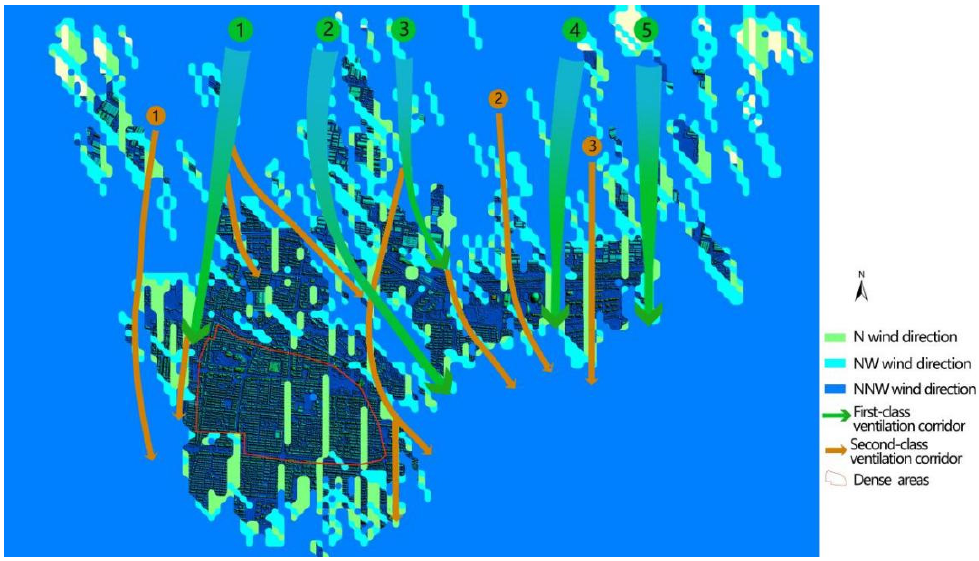
Figure 19. The results of the automatic mining of a 70 m width and 500 m corridor (DSM + corridor).